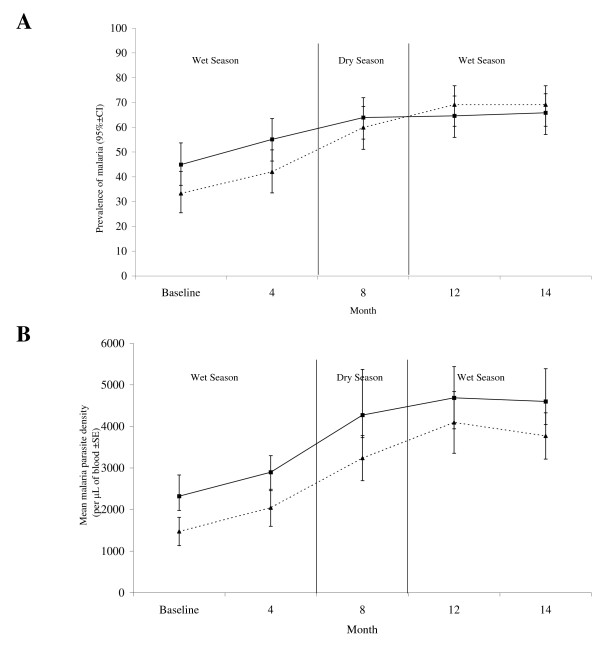
(A) Prevalence rates (Plasmodium spp.) and (B) mean malaria parasite density in treatment (solid line) and placebo (dotted line) groups during the follow-up period. Treatment group n = 158, Placebo group n = 162.